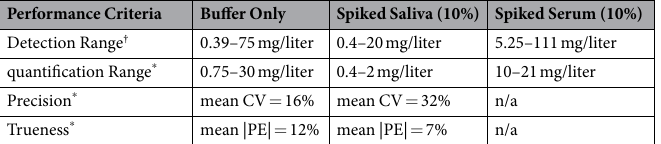
Table 2. Summary of HGD65 detection and quantification performance. † The qualitative (detection) ranges listed are concentrations at incubation. Nanopore groupings: buffer only, P7-P15 and P27-P28; saliva, P21- P26; serum, P18-P20. 1 nM = 0.15 mg/liter for 150 kDa Ab. * Quantitative ranges listed are concentrations at incubation and correspond to the combined estimates reported in Table 1 and plotted in Fig. 5. Nanopore groupings: buffer only, P7-P15; saliva, P21-P26; serum, P18 alone. Mean coefficient of variation (CV) and mean absolute value of percent error (|PE|) are across the corresponding subgroups (P18: CV, PE not available (n/a) without